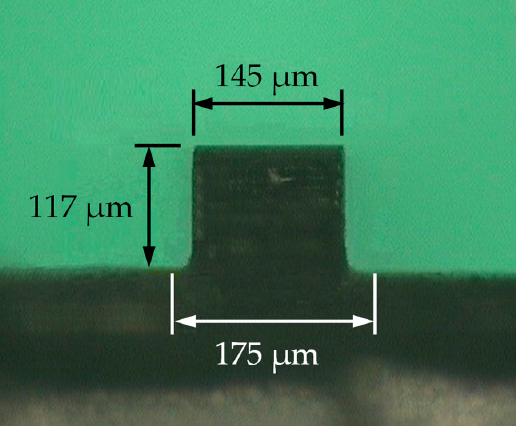
Figure 4. Micro embossment on the surface of the ultrasonic vibrator, machined by electrical discharge.